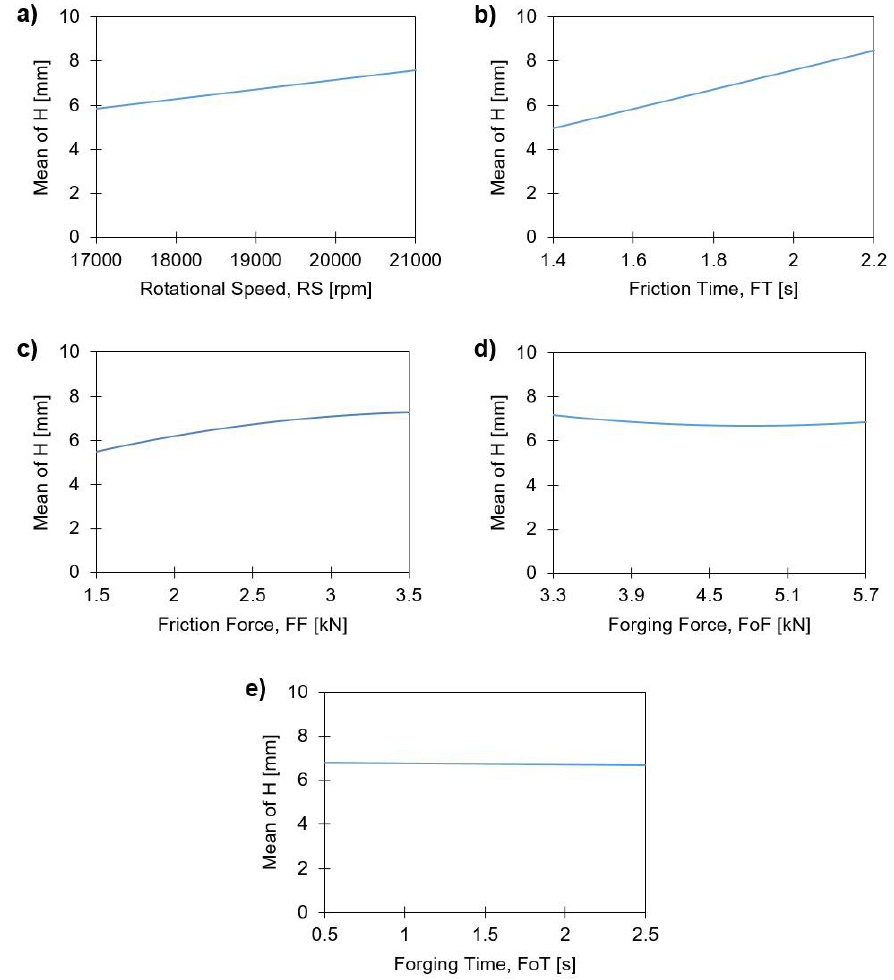
Figure 10. Main effects plots of the rivet penetration depth, H, with: ( a ) rotational speed; ( b ) friction time; ( c ) friction force; ( d ) forging force; and ( e ) forging time.